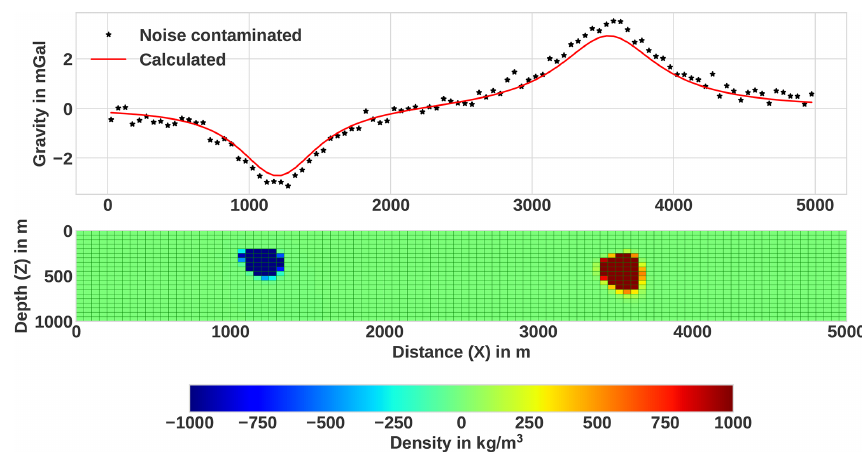
Figure 9. Inversion result obtained using only the commonly used criterion ( | misfit k − 1 − misfit k | ) and the corresponding data fit (upper panels) for the synthetic example in Fig. 8a. The obtained density model shows that the compact and sharp model was not approximately achieved due to the termination before the iterative procedure had reached convergence.